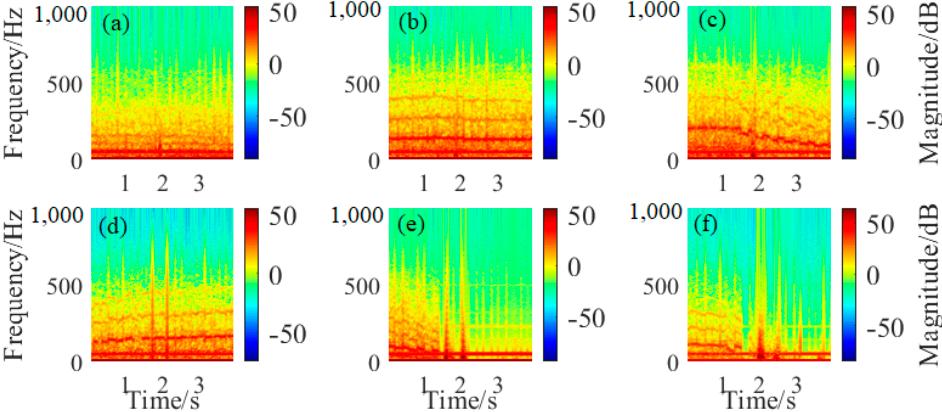
Figure 6. Short time Fourier transform (STFT) for different wire rope defect signals: ( a ) for signals from defect 1; ( b ) for signals from defect 2; ( c ) for signals from defect 3; ( d ) for signals from defect 4; ( e ) for signals from defect 5; and ( f ) for signals from defect 6.